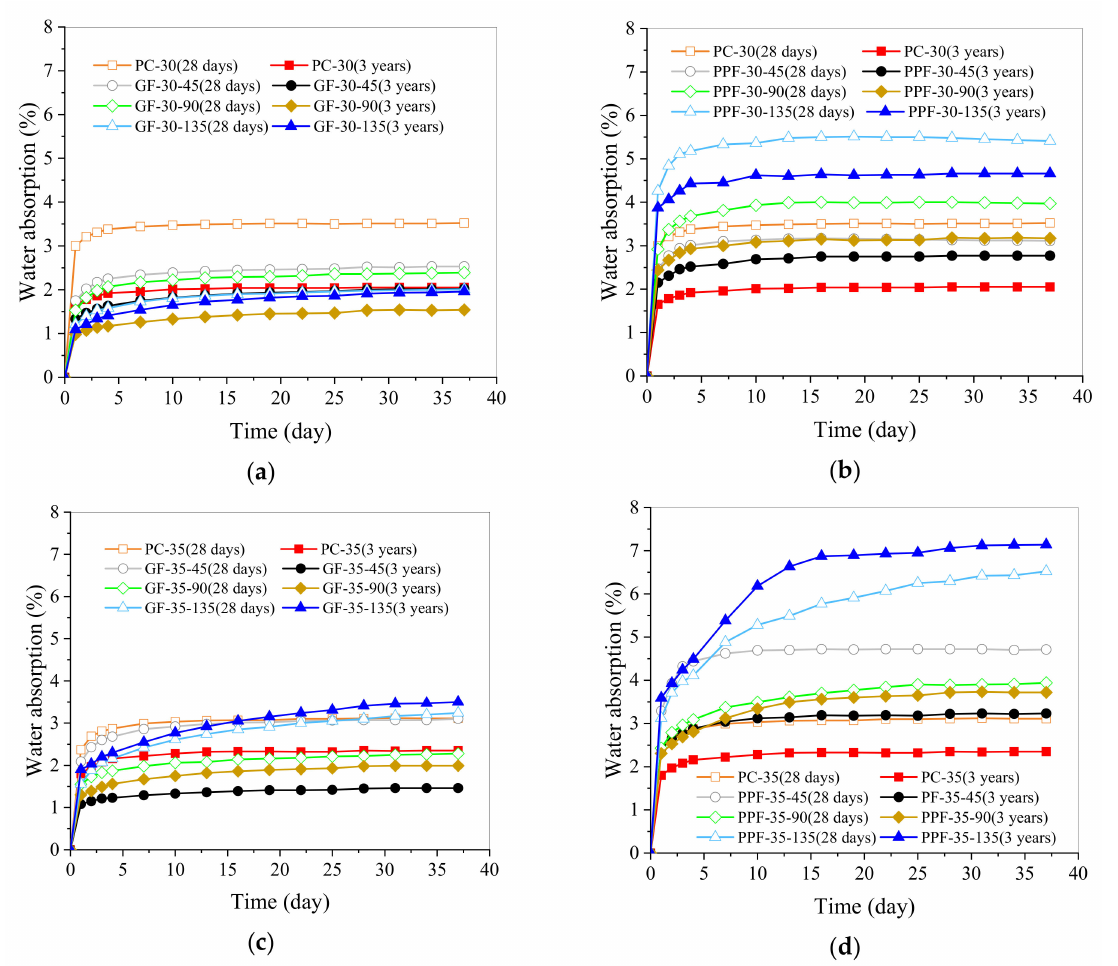
Figure 6. The full curves of the water absorption of the specimens: ( a ) Full curves of the water absorption of the GFRC when w/b = 0.30; ( b ) Full curves of the water absorption of the PPFRC when w/b = 0.30; ( c ) Full curves of the water absorption of the GFRC when w/b = 0.35; ( d ) Full curves of the water absorption of the PPFRC when w/b =